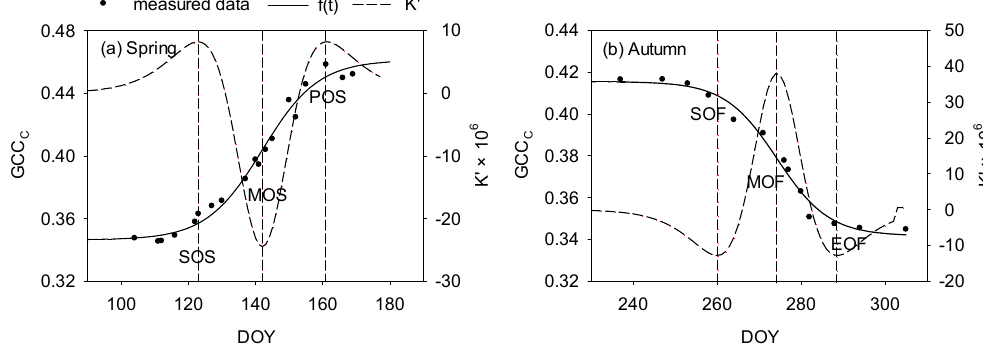
Figure 1. Illustration of the methods used to extract spring ( a ) and autumn ( b ) phenophases in the green chromatic coordinate from camera (GCC C ) in 2015. f(t) is the fitted function, K’ is the curvature change rate of f(t). SOS: start of spring, MOS: middle of spring, POS: peak of spring, SOF: start of fall, MOF: middle of fall, EOF: end of